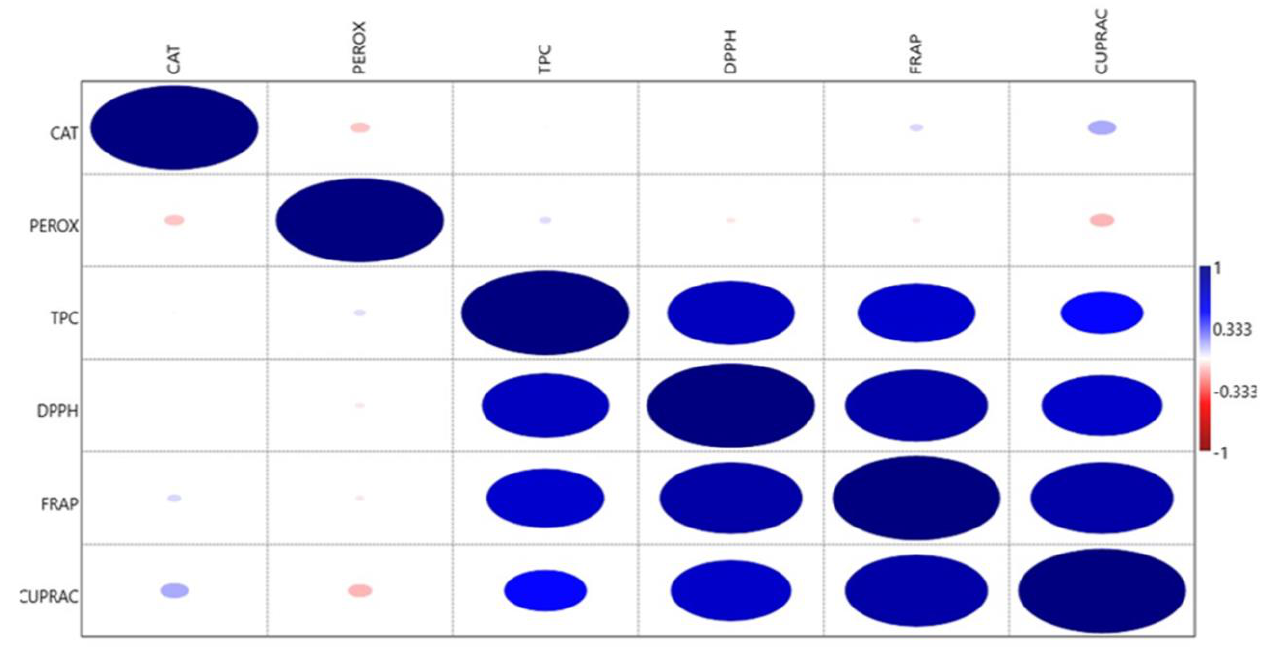
Figure 4. Heat map showing Pearson’s correlation coefficients for the antioxidant traits. Significant correlations are colored either red (negative) or blue (positive). Shades of blue indicate increasing positive correlation coefficient; shades of red indicate increasing negative correlation coefficient. CAT: catalase (unit min − 1 g − 1 ); PEROX: guaiacol peroxidase (unit min − 1 g −1 ); TPC: total phenolics content (mg catechol or CE 100 g − 1 ); DPPH: 2, 2-diphenyl-1-picrylhydrazyl (% inhibition); FRAP: ferric reducing antioxidant power activity (µg ascorbic acid equivalent or AAE) g − 1 ; CUPRAC: c upric ion reducing antioxidant capacity (μg trolox equivalent or TE) g −1 ).